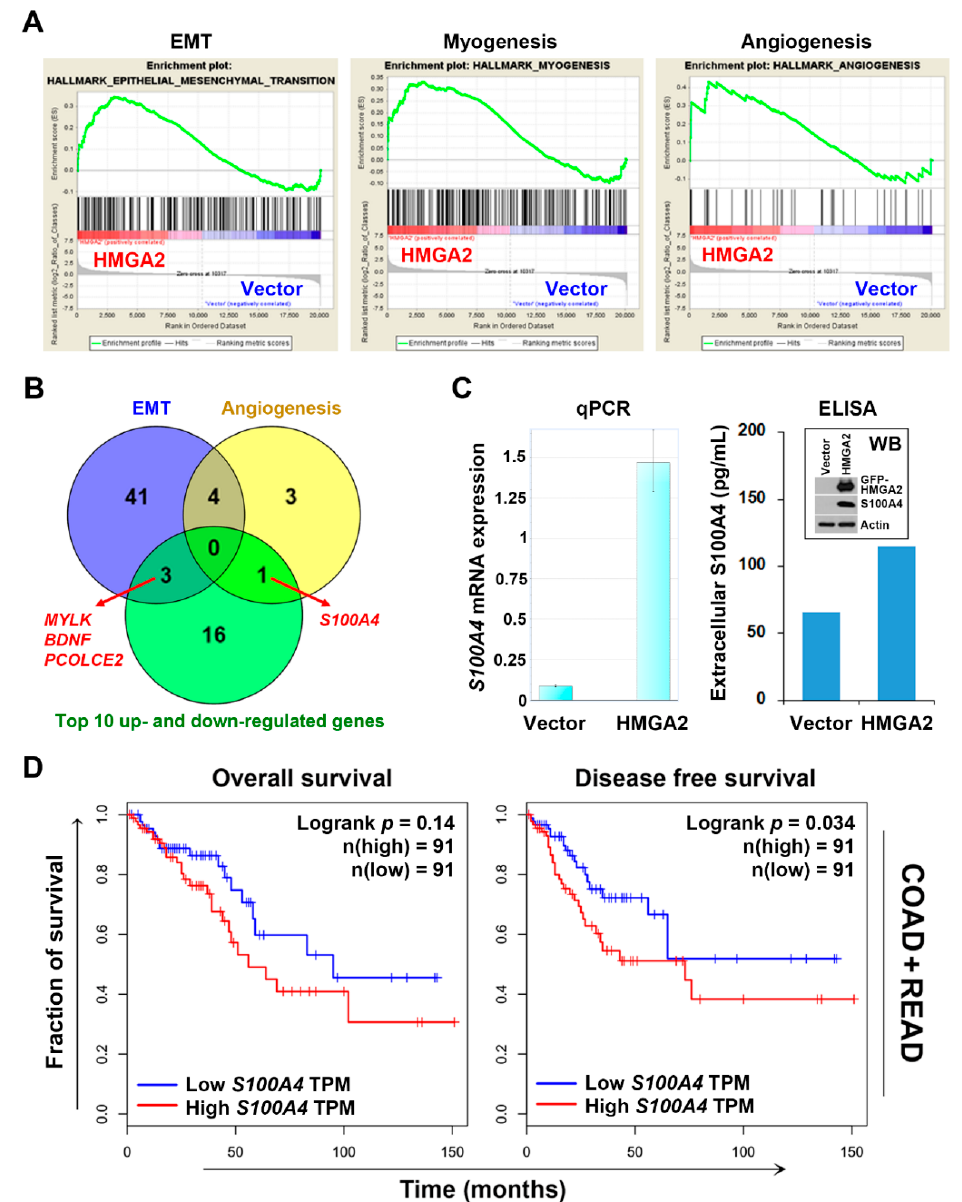
Figure 4. Upregulation of S100 calcium-binding protein A4 (S100A4) in HMGA2-overexpression colorectal cancer cells. ( A ) The differentially expressed genes (DEGs) in DLD-1-HMGA2 cells were analyzed by Gene Set Enrichment Analysis (GSEA) for hallmark enrichment; ( B ) a Venn diagram for the overlapped genes among epithelial–mesenchymal transition (EMT) and angiogenesis hallmarks, and top 10 up- and down-regulated DEGs in DLD-1-HMGA2 cells; ( C ) the mRNA and protein expressions of S100A4 in DLD-1-Vector and DLD-1-HMGA2 cells were analyzed by qPCR and Western blotting (WB), respectively. The level of S100A4 protein in the 24-h culture medium from DLD-1-Vector and DLD-1-HMGA2 cells was detected by enzyme-linked immunosorbent assay (ELISA); ( D ) the Kaplan–Meier survival plots for colorectal cancer patients with high and low S100A4 expression were generated using the GEPIA database. TPM, transcript per million.